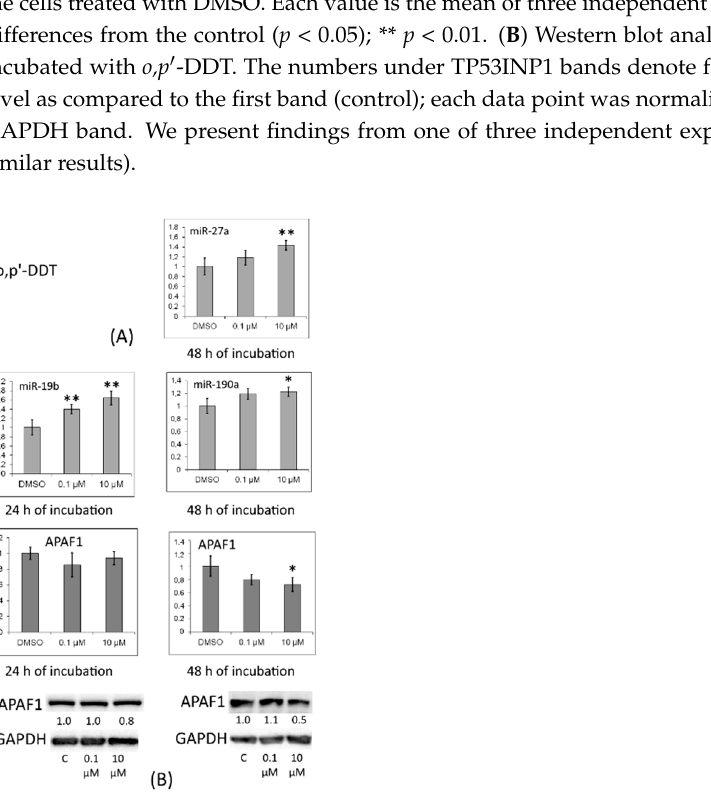
Figure 8. ( A ) Relative levels of APAF1 mRNA and of miRNAs targeting it (miR-193b and miR-342) in MCF-7 cells exposed to p,p ′ -DDT. The Y-axis represents the ratio of the mRNA or miRNA amount in the cells treated with a DDT isomer to the mRNA or miRNA amount in the cells treated with DMSO. Each value is the mean of three independent experiments. * Significant differences from the control ( p < 0.05); ** p < 0.01. ( B ) Western blot analysis of APAF1 in cells incubated with p,p ′ -DDT. The numbers under APAF1 bands denote fold change in the protein level as compared to the first band (control); each data point was normalized to the corresponding GAPDH band. We present data from one of three independent experiments (which yielded similar results).